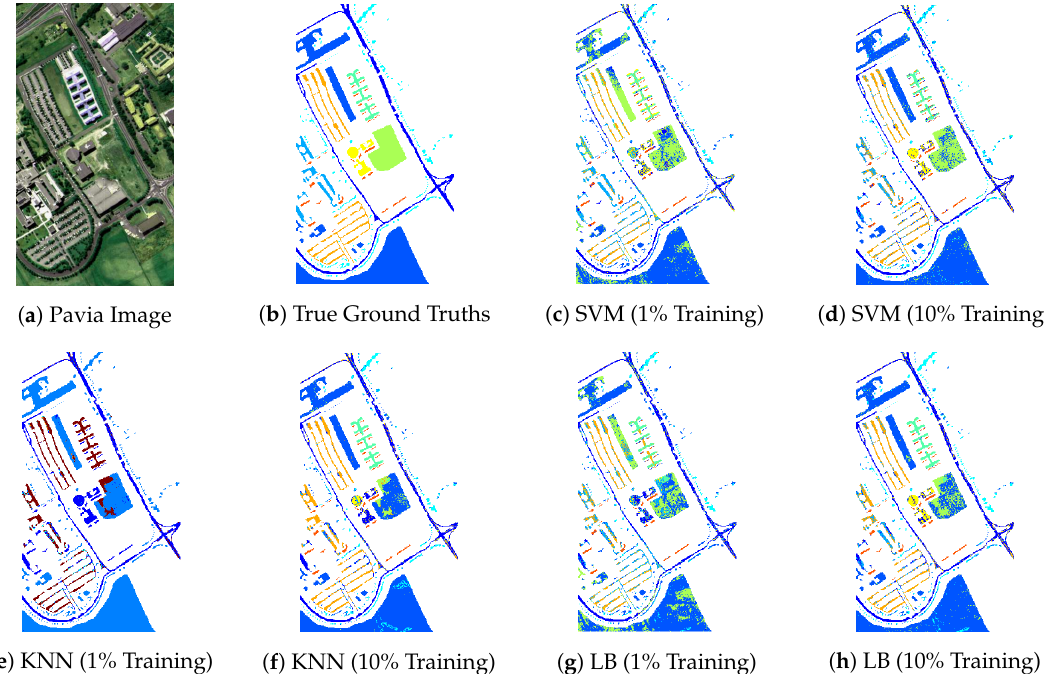
Figure 1. ( a ) Pavia University image; ( b ) True ground truths differentiate nine different classes; ( c ) SVM trained with 1% randomly selected training samples; ( d ) SVM trained with 10% randomly selected training samples; ( e ) KNN trained with 1% randomly selected training samples; ( f ) KNN trained with 10% randomly selected training samples; ( g ) Logistic boost (LB) trained with 1% randomly selected training samples; ( h ) LB trained with 10% randomly selected training samples. Table 1. Classification accuracies in-terms of overall and kappa ( κ ) obtained by three different classifiers with two different number of randomly selected labeled training samples, i.e., 1% and 10% respectively. All these classifiers are trained and tested using 5-fold cross validation, and from results one can conclude that SVM produce better results when trained with 10% randomly selected training